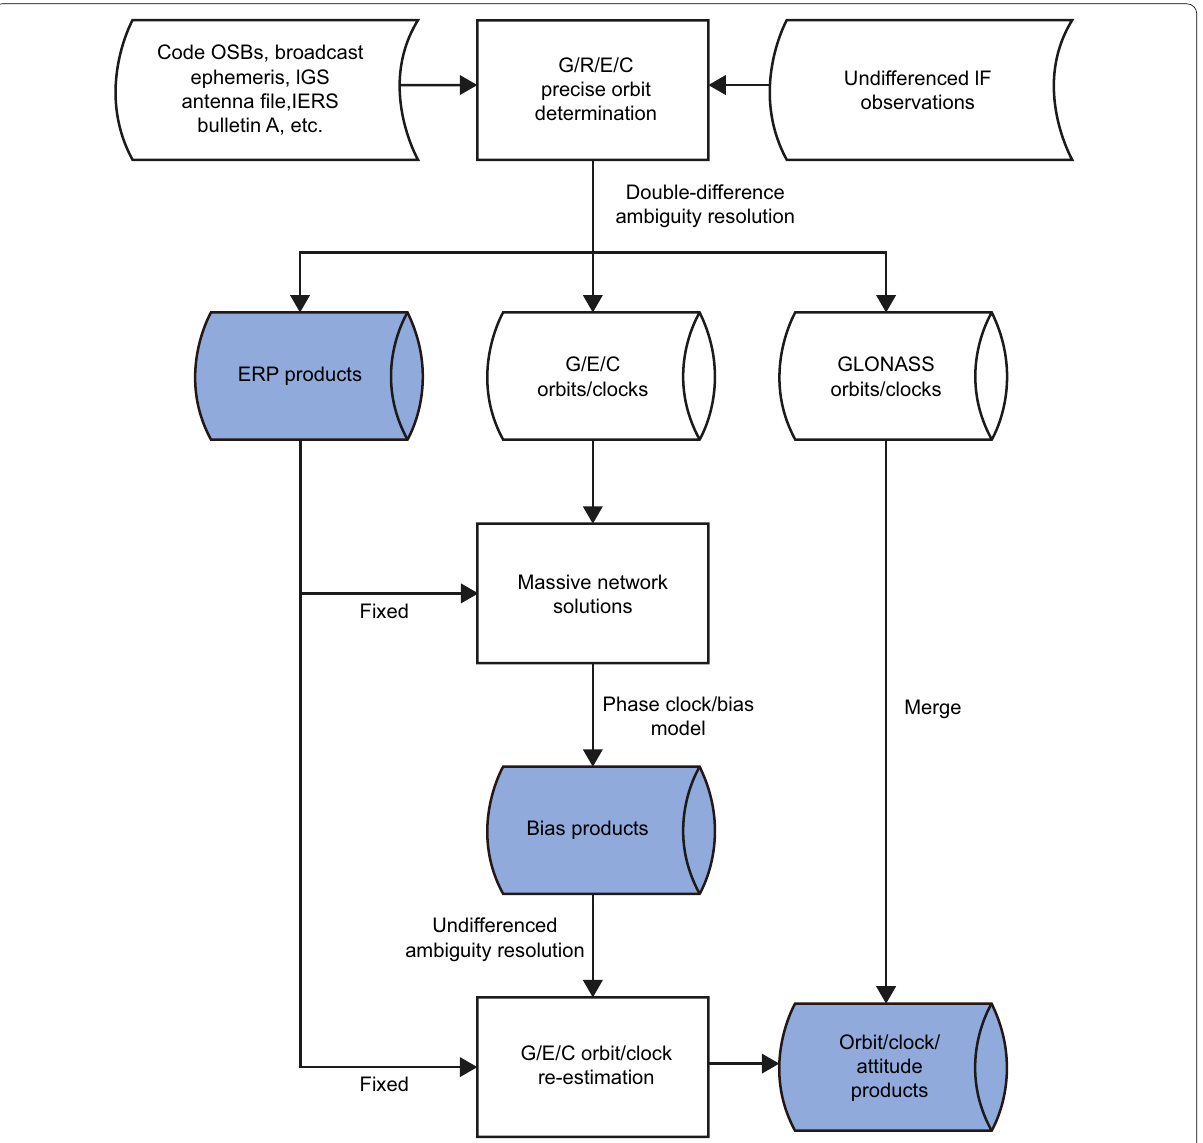
Fig. 1 Flowchart of WUM rapid phase clock/bias and orbit products generation procedure. Charts in blue depict the ultimate products. G, R, E, C represent GPS, GLONASS, Galileo, BDS